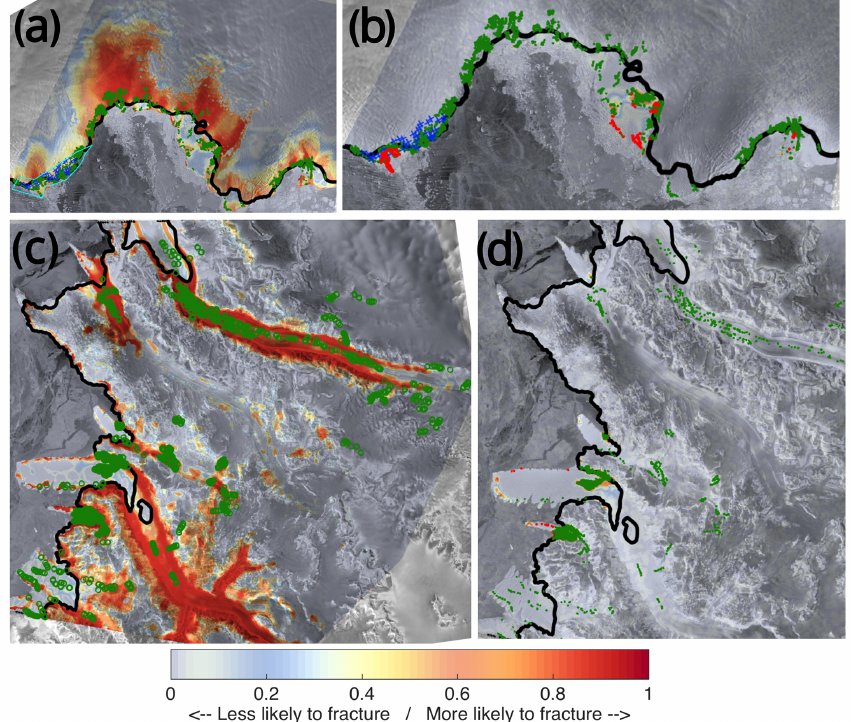
Figure 9. Modelled probability of a fracture vs. modelled damage for Holmes IS (group 3) (a, b) and Nansen IS (group 1) (c, d) . Labels are the same as in Figs. 5 and